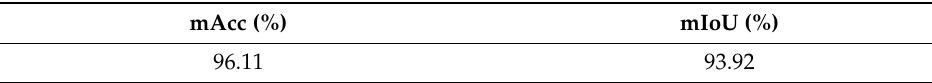
Table 3. Evaluation of averaged class extraction